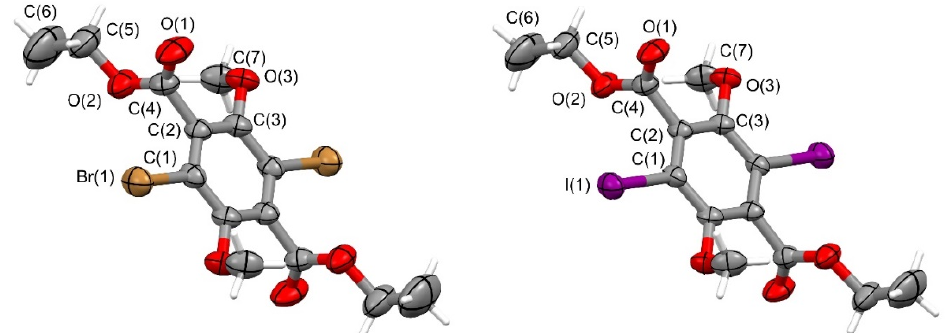
Figure 2. Thermal ellipsoids of the molecular compound 4a ( left ) and 4b ( right ) (ellipsoids are drawn at the 50% probability level; atom names are reported only for the asymmetric unit and an inversion center occurs at the center of the aromatic ring).